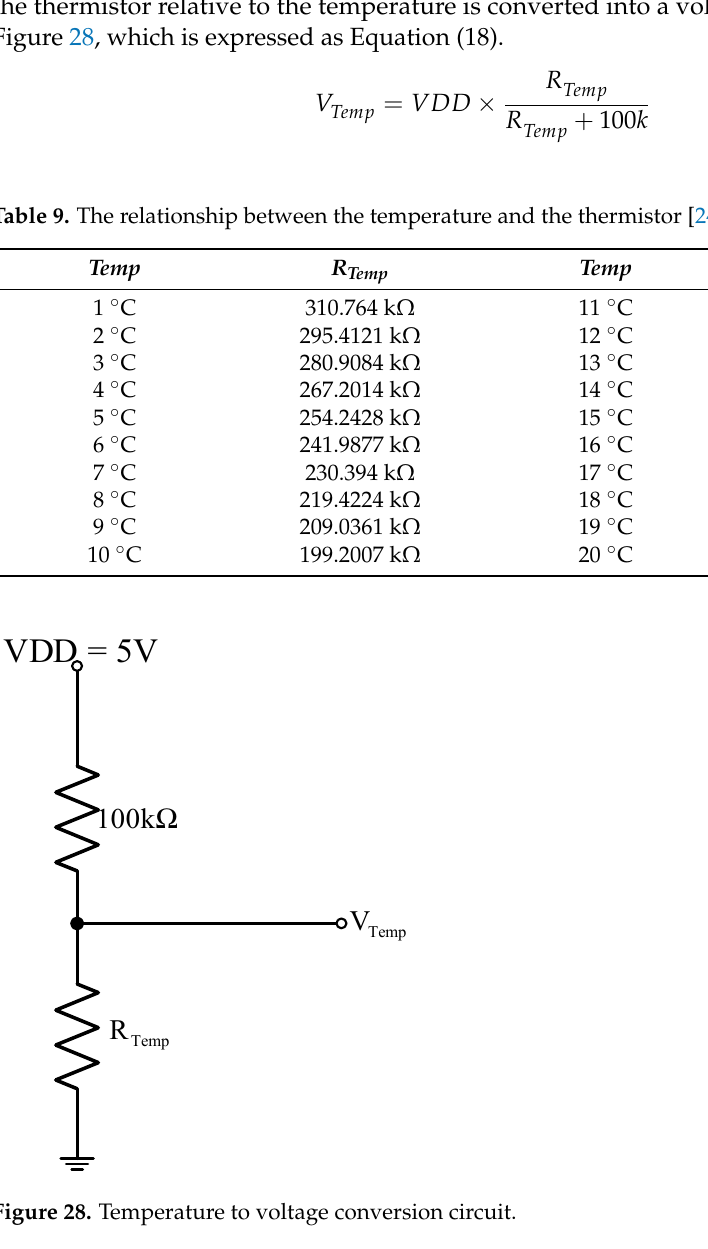
Table 8. Comparison with the output current THD i of two types of drives.